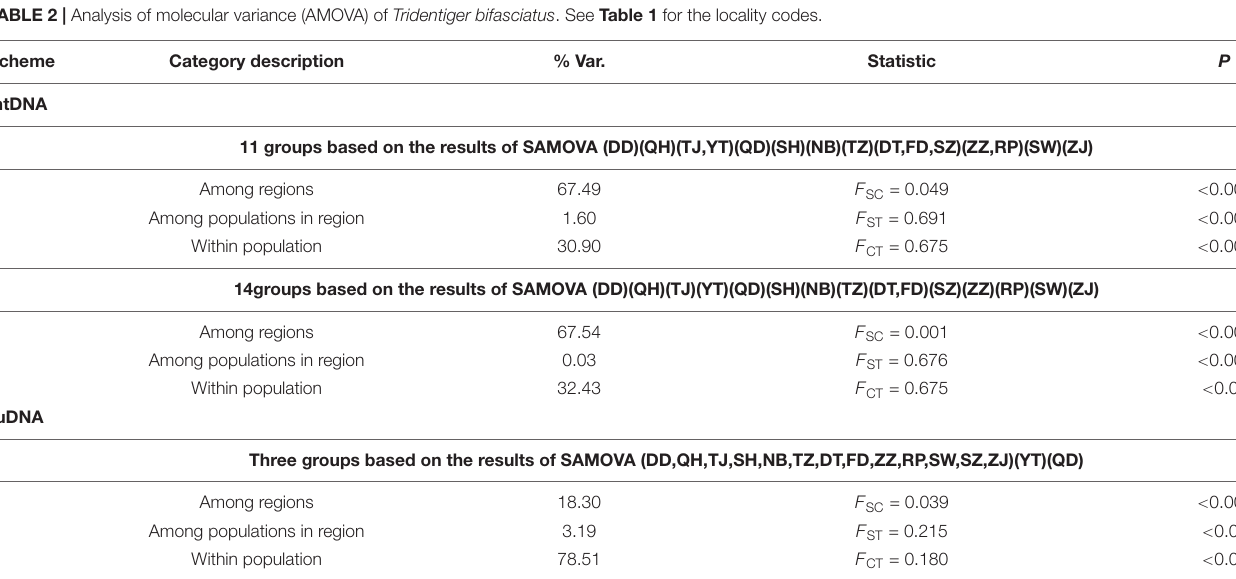
TABLE 2 | Analysis of molecular variance (AMOVA) of Tridentiger bifasciatus . See Table 1 for the locality codes.